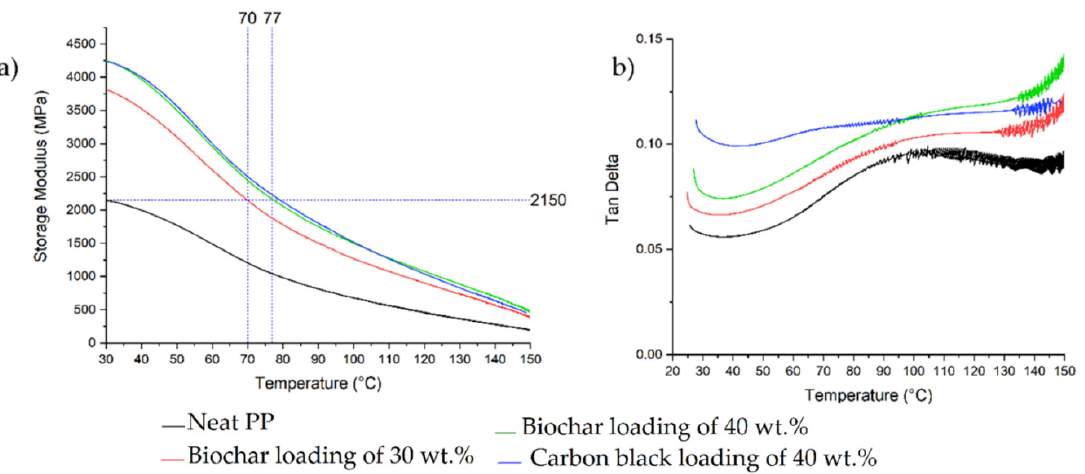
Figure 3. Storage modulus ( a ) and tan delta ( b ) of different composites containing biochar with a loading of 30 wt%, 40 wt%, and carbon black with a loading of 40 wt%.